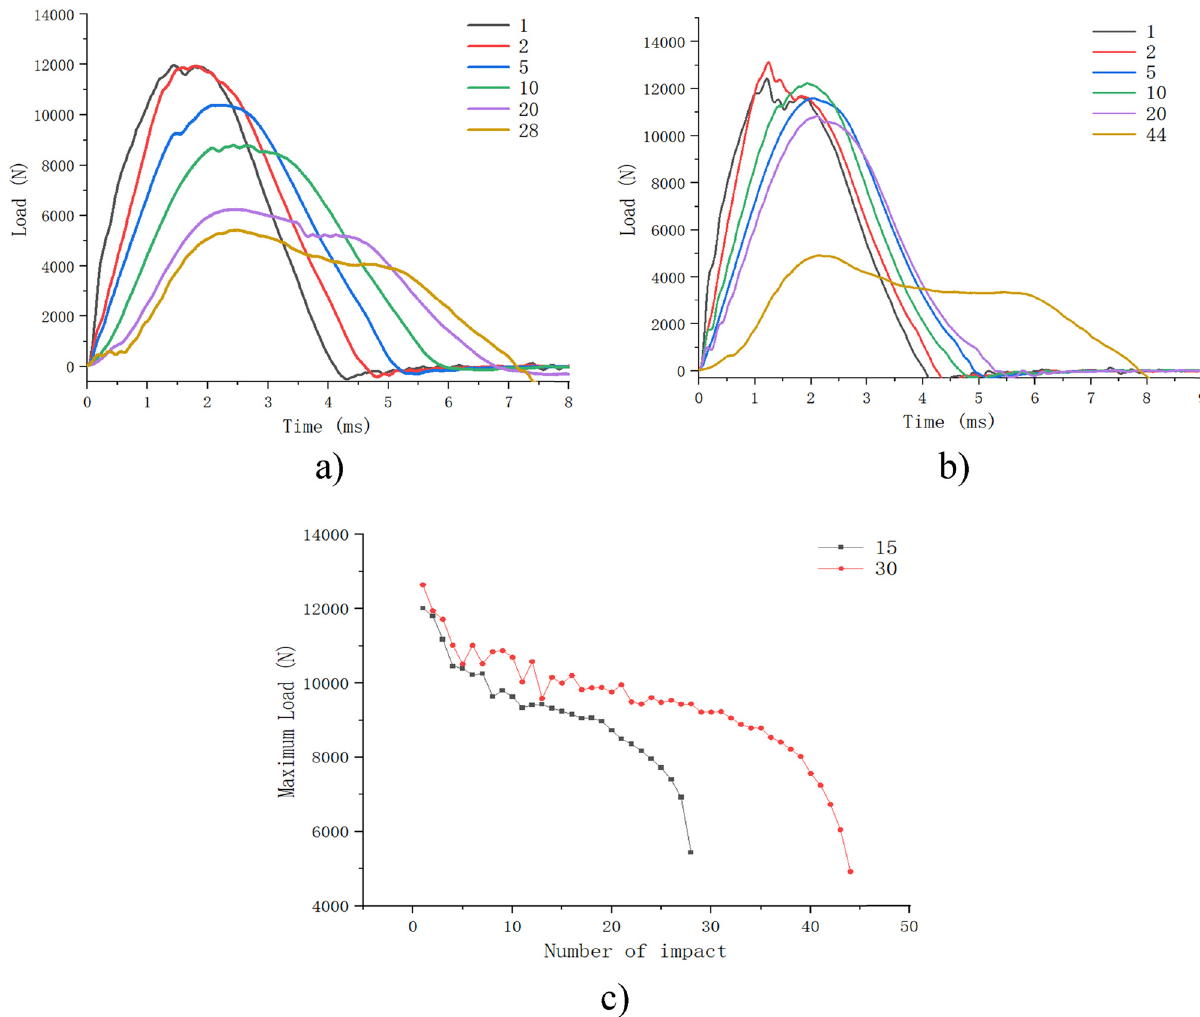
Figure 4: Time – load plot and number of impacts – peak load plot: ( a ) time – load diagram for multiple impacts with a braid angle of 15°, 1, 2 … 28 are the number of impacts, ( b ) time – load diagram for multiple impacts with a braid angle of 30°, 1, 2 … 44 are the number of impacts, and ( c ) number of impacts – peak load plot, 15 and 30 are the braiding angles being